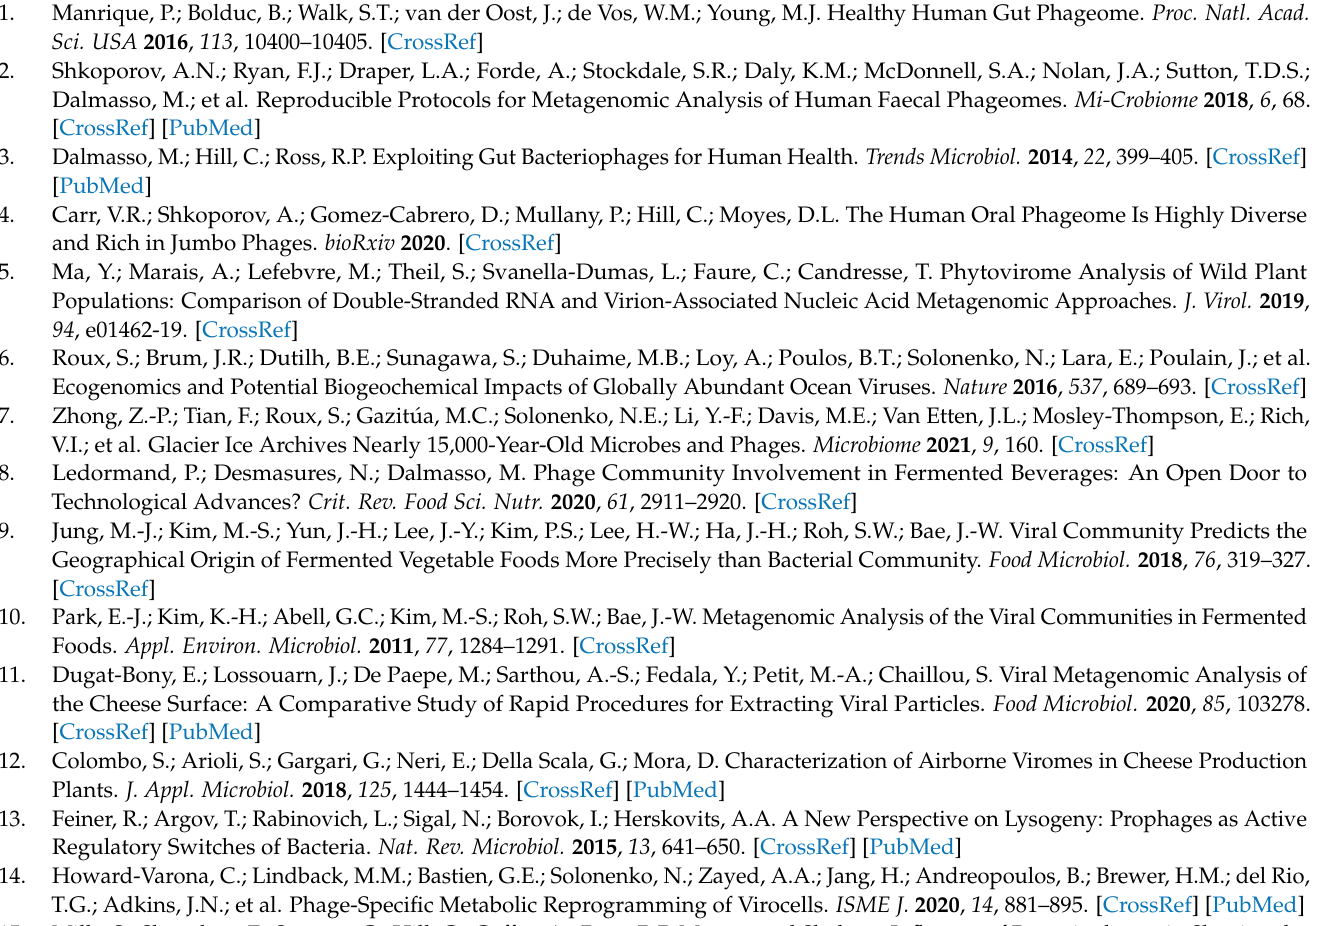
Figure S3: Eukaryota taxonomic assignations at the genus level during the cider fermentation process for two producers (B: industrial and P: hand-crafted). Figure S4: Bacterial taxonomic assignations at the family level during cider fermentation process for two producers (B: industrial and P: hand-crafted). Table S1: Percentage of the number of reads attributed to Super-kingdoms in NCBI. Table S2: Bacterial strains used to isolate bacteriophages. Table S3: Occurrence of prophages for producer B and